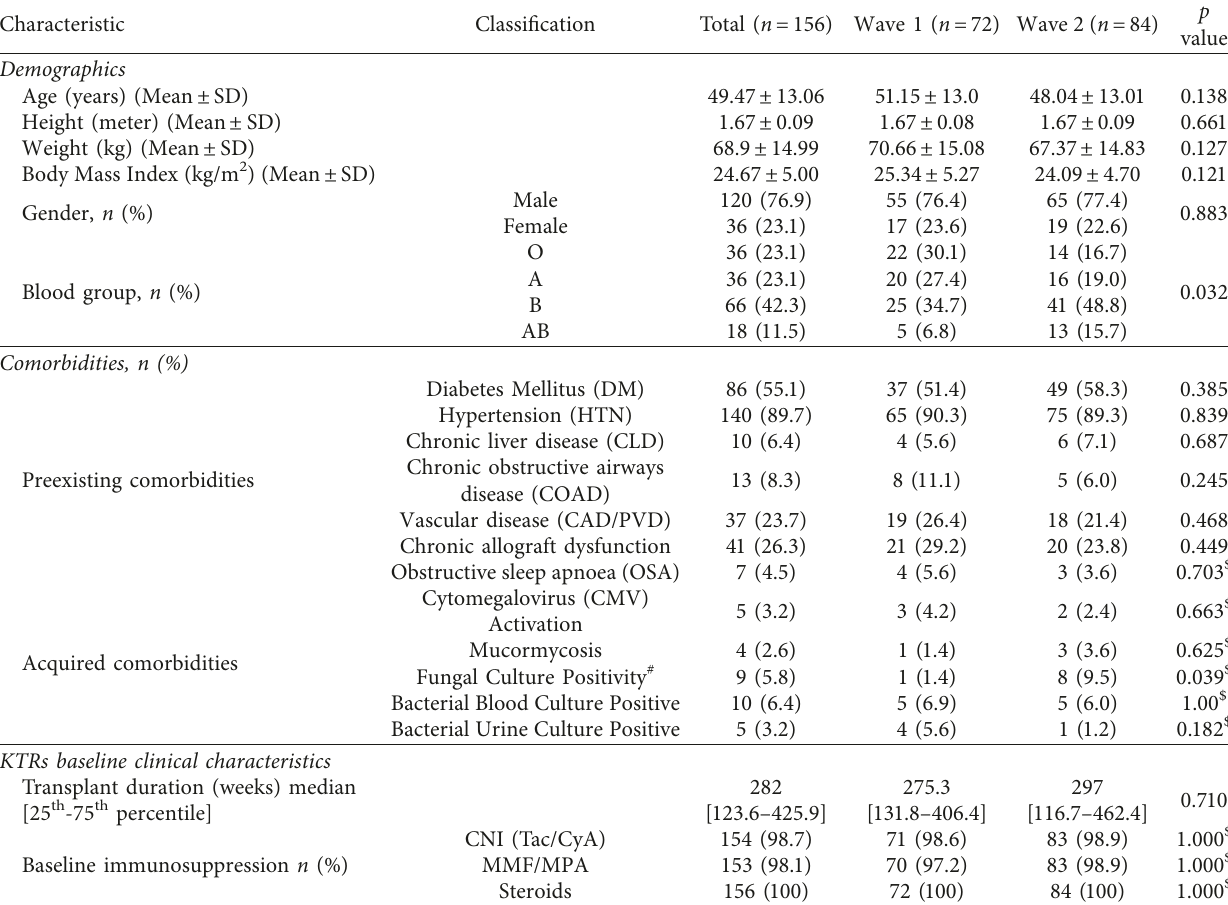
Table 1: Demographics, comorbidities, and baseline kidney transplant recipients (KTRs) characteristics at the time of diagnosis of COVID- 19 in two waves of disease.